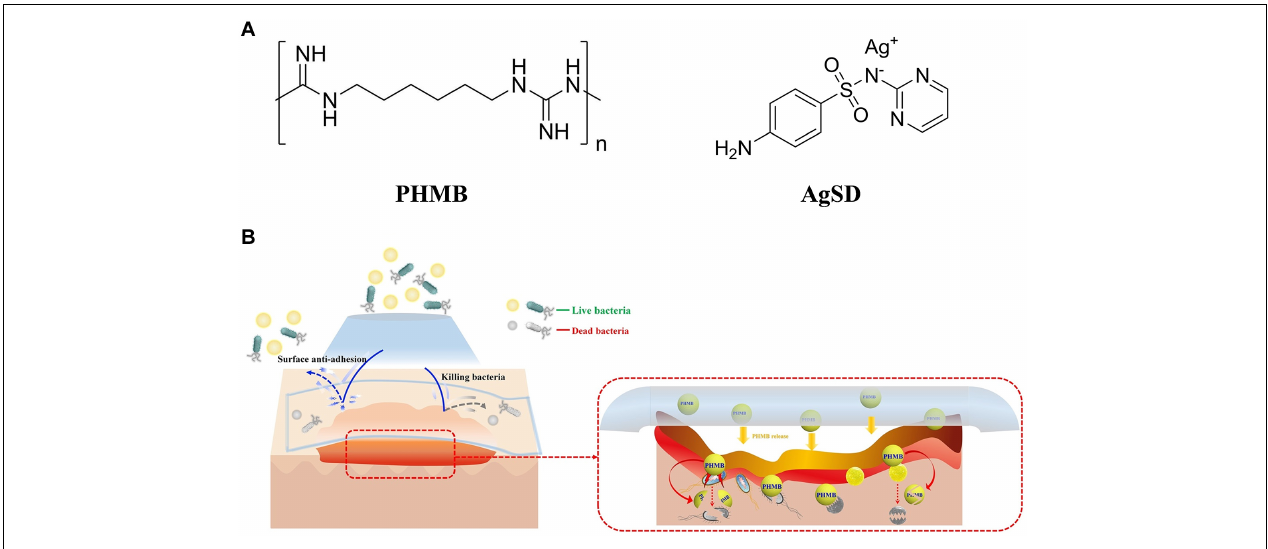
FIGURE 8 | (A) Molecular formula of fungicides PHMB and AgSD. (B) Multifunctional antibacterial effect of PHMB-PBC composites (Wang et al., 2019).